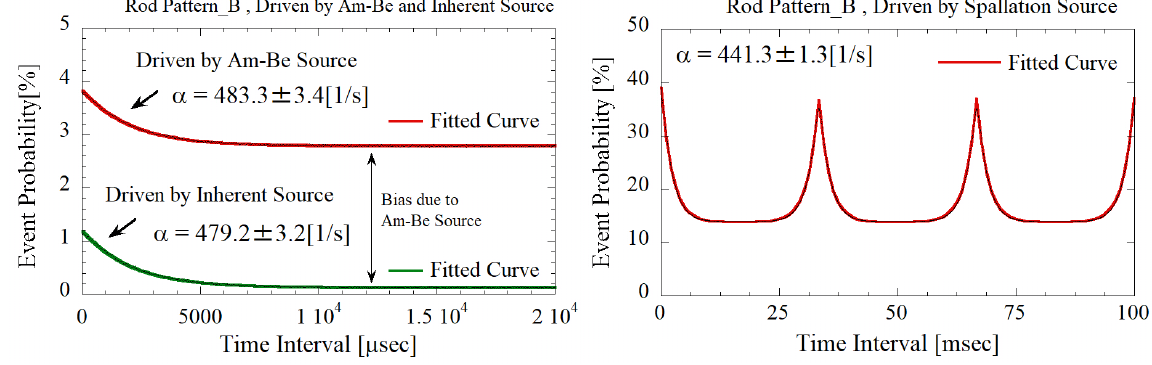
Figure 6. Result of Rossi- α analysis Figure 7. Result of Rossi- α analysis. (Am-Be and Inherent Source). (Spallation Source).